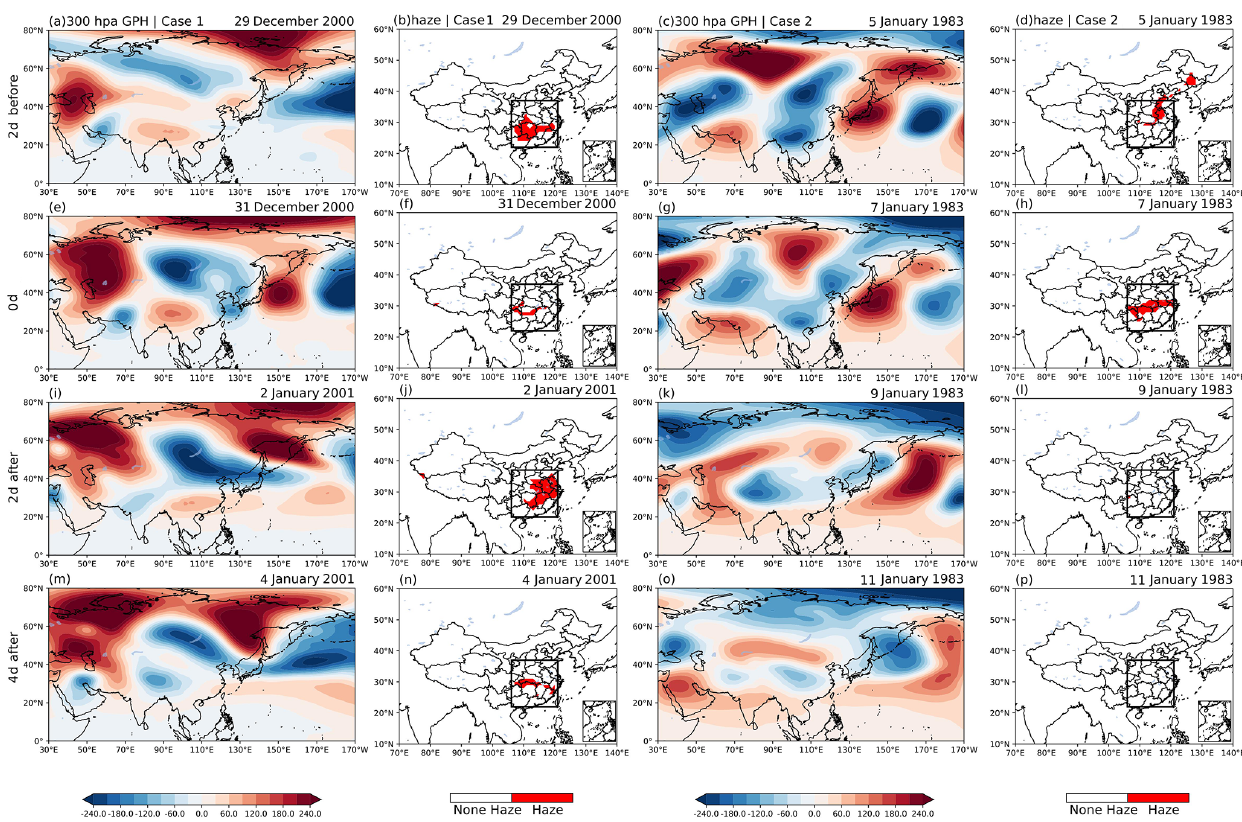
Figure 2. Composite of GPH anomalies (shading; gpm) at 300hPa from − 2 to 4d for the case 1 CS outbreak on 31 December 2000 (a, e, i, m) and the case 2 CS outbreak on 7 January 1983 (c, g, k, o) and the related spatial distribution of HD EC (shading) (b, f, j, n) and (d, h, l, p)